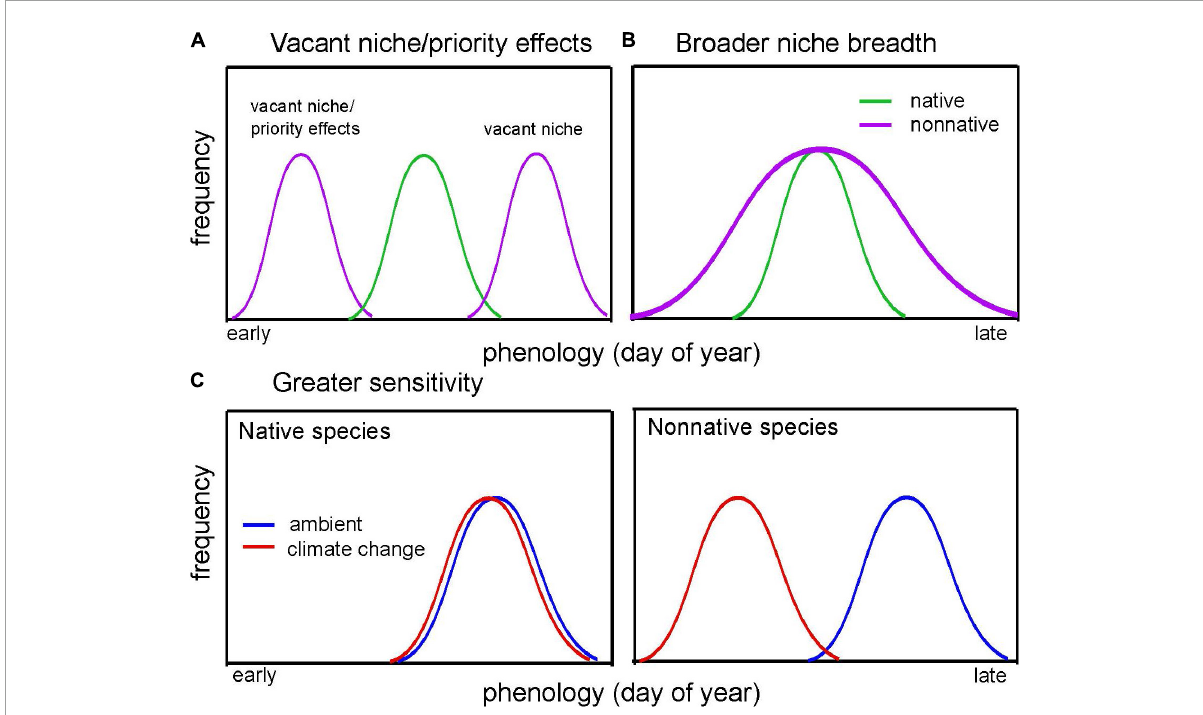
FIGURE1 Conceptual diagram illustrating the four hypotheses proposed by Wolkovich and Cleland (2011; shown in italics) to explain how phenology may shape invasion. Each line represents the phenology of a species across a growing season. In (A) , non-native species (purple) fill a vacant niche in time, either earlier (also known as priority effects ) or later than native species (green). In (B) , non-native species have a longer duration of phenology than native species, filling a broader temporal niche than natives. Here, Q1 addresses whether non-native species demonstrate earlier or later phenology (vacant niche/priority effects) or shorter or longer phenological duration (niche breadth) relative to native species. In (C) , native species’ (left) phenology occurs at a similar time under both ambient (blue) and climate change (red) conditions, whereas non-native species (right) can shift their phenology earlier in the season (i.e., are more phenologically sensitive to climate). Here, Q2 addresses whether non-native species demonstrate greater or less sensitivity to climate than native